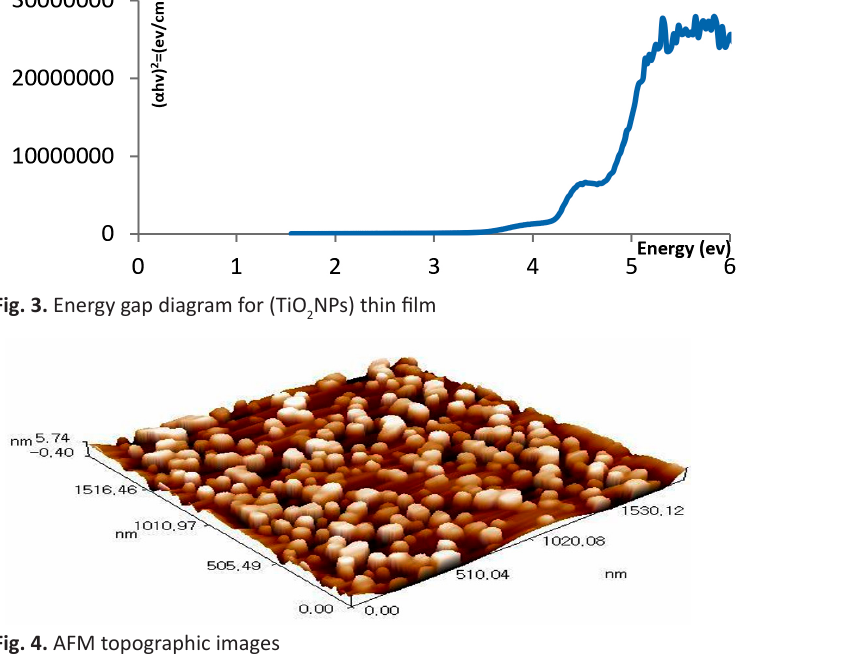
Fig. 4. AFM topographic images